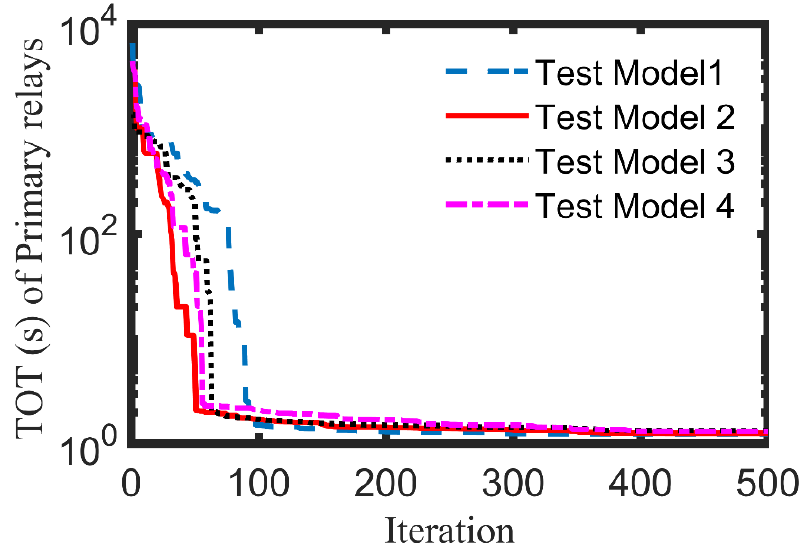
Figure 7. FOF convergence of Agiba test network using scenario 1 settings.